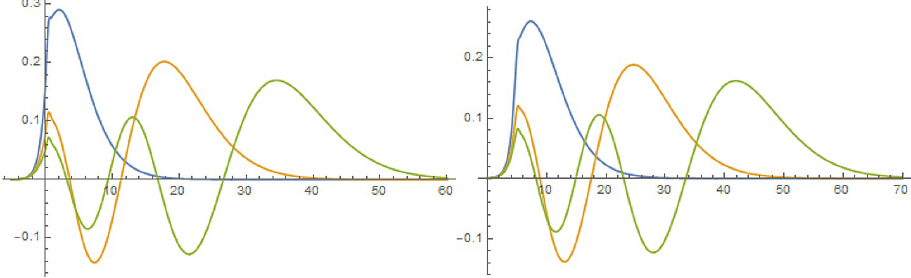
Fig. 5 . Three leading wave function (n = 1,3,5) for the scale k = 0.54 and 5.0 GeV as a function of ln q 2